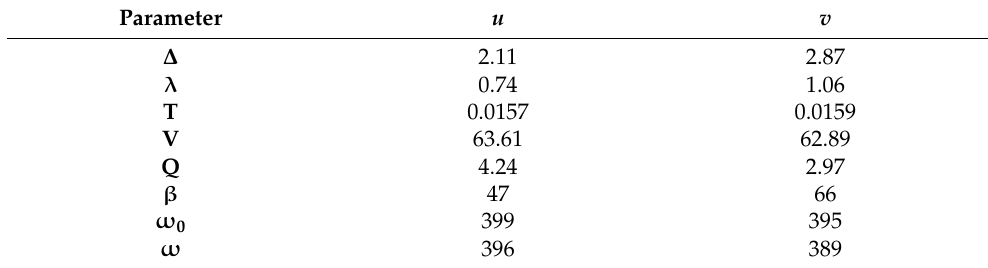
Table 1. The parameters obtained in the study of damped oscillations, where ∆ is the decay decrement, λ is the logarithmic decay decrement, T is the period (second), and V is the frequency (Hz). Also, in the course of the study, the values of Q –factor, cyclic ω 0 , and natural ( second − 1 ) frequency were obtained.